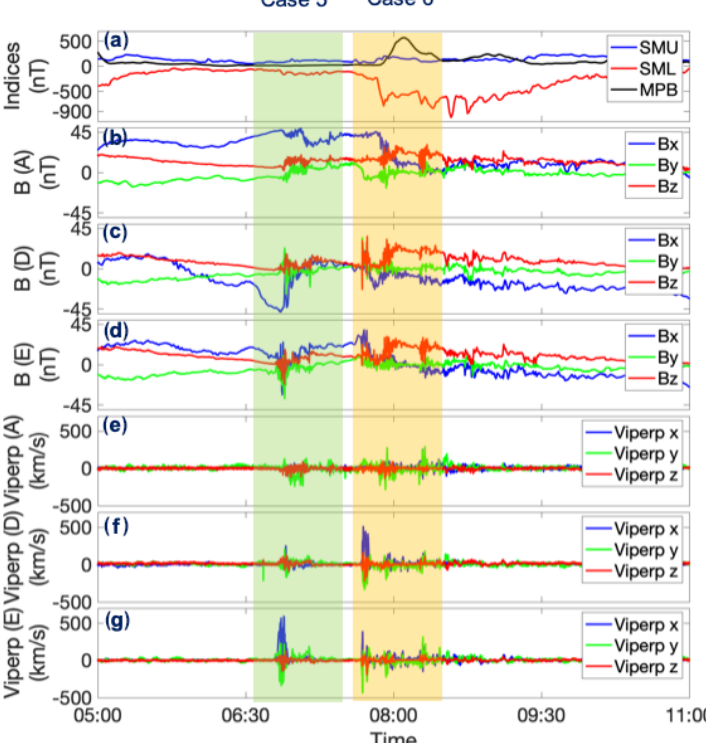
Figure 3. THEMIS spacecraft in situ measurements for fast flow burst Cases 5 and 6 that were observed on 10 December 2015. The caption of Fig. 1 applies.